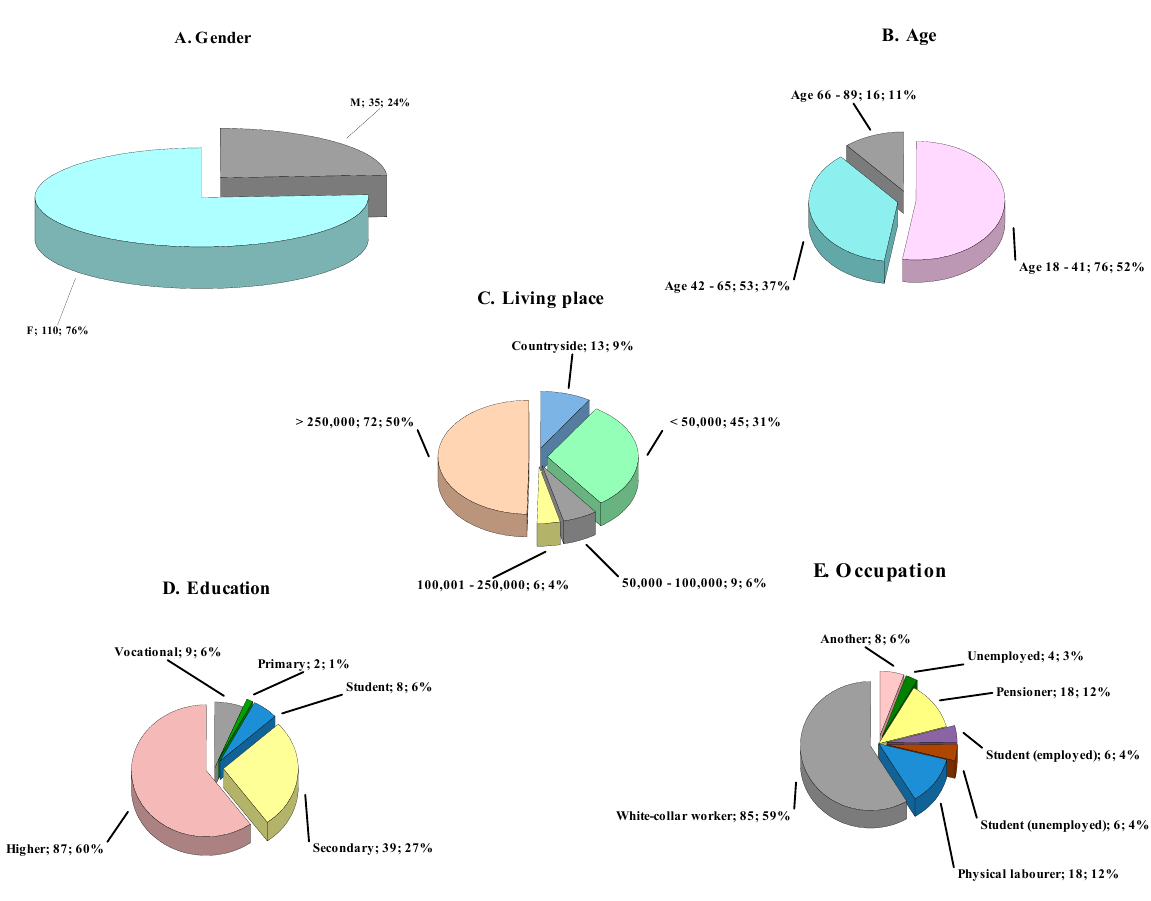
Figure 1. ( A ) Gender of questioned individuals. The segment description includes the gender (F = female; M = male), followed by the respondents’ number in this gender and percentage of total respondents, respectively. ( B ) Age of sur- veyed individuals. The segment description includes the respondents’ number aged in this range, followed by the per- centage of the total respondents. ( C ) Living place of questioned participants. The segment description includes the city population, followed by the number of respondents inhabiting a given city and percentage of total respondents, respec- tively. ( D ) Education level of interviewees. The segment description includes the education level, followed by the number of respondents with that education stage and the percentage of total respondents, respectively. ( E ) Occupation of sur- veyed individuals. The segment description includes the employment, followed by the number of respondents who work in this profession and the percentage of total respondents,